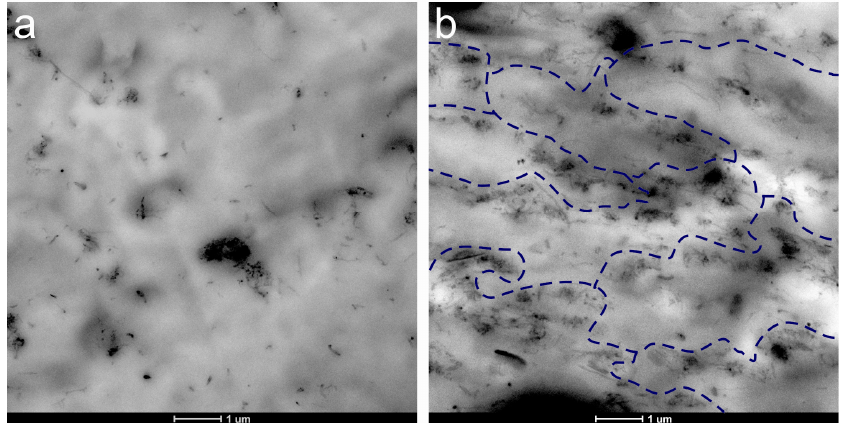
Figure 10. TEM micrographs of nanocomposites: ( a ) 2 wt.% MWCNT/PP; ( b ) 4 wt.% MWCNT/PP. Tentative pathways formed by nanotube agglomerates are marked by dashed blue lines in the case of 4 wt.%